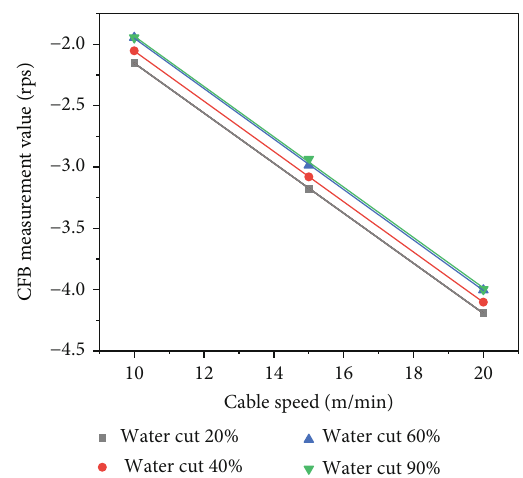
Figure 7: Relational graph of the measured value of 93 ° inclination of 100m 3 /d CFB and cable